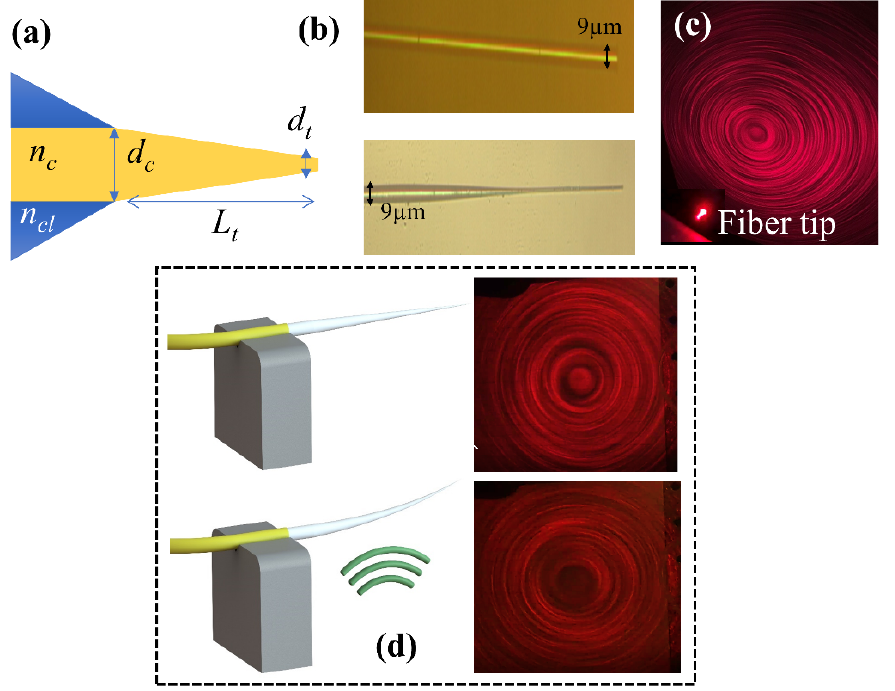
Figure 1. ( a ) Schematic of the tapered-tip fiber with relevant design parameters. ( b ) Microscope image of the fiber before etching ( top ) and after etching ( bottom ). ( c ) The output fringe pattern of the tapered-tip fiber in air, and the red spot is the tip. ( d ) The change in output fringe pattern upon acoustic field excitation. The top image is when the transducer is off, and the bottom image is when it is on.